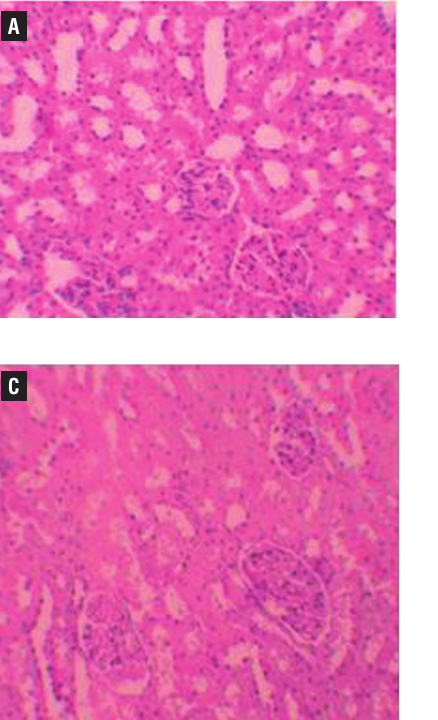
figure 1 - A) normal tubulus and glomerules in kidney kortex h&Ex200 (control group). B) normal tubulus and glomerules in kidney kortex h&Ex200 (sham group). C) severe tubules total necrosis, tutbular degeneration and epithelial vacuolization in proximal tubules h&Ex200 (uuO group). D) mild epithelial vacuolization in the proximal tubules and normal glomerules h&Ex200 (uuO+nahs treated